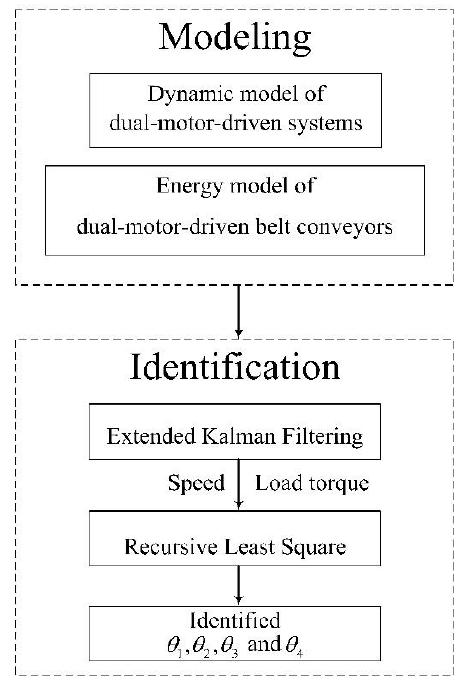
Figure 2. The flowchart of the research.